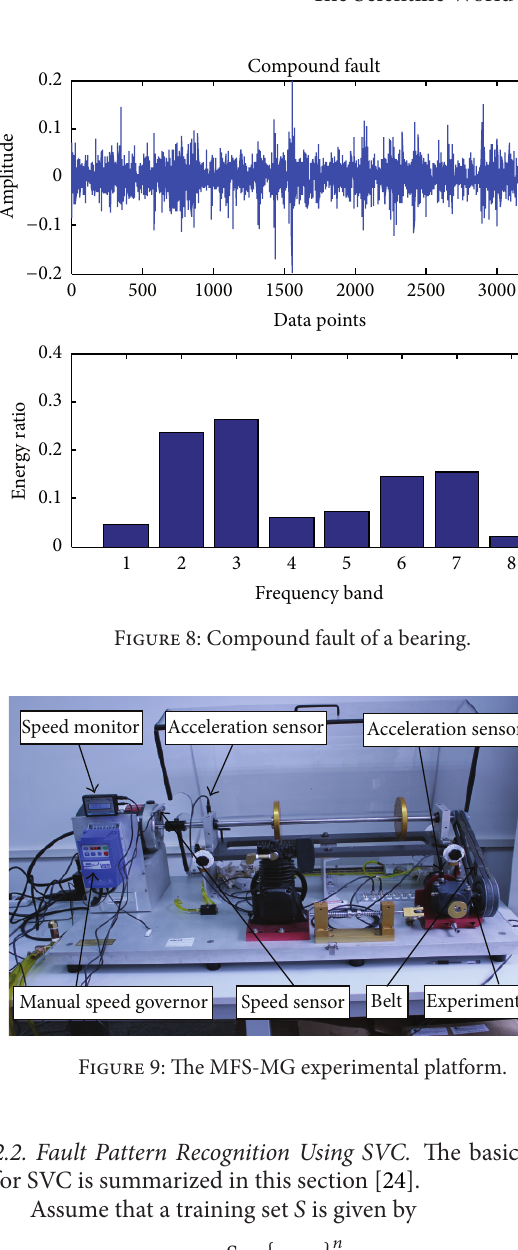
Figure 7: Outer race fault.